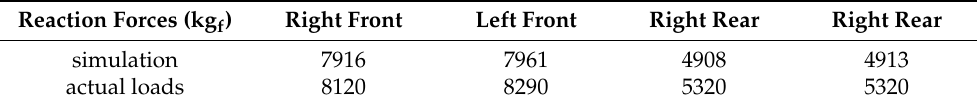
Table 3. Comparison between the simulation result and actual load of reaction force.